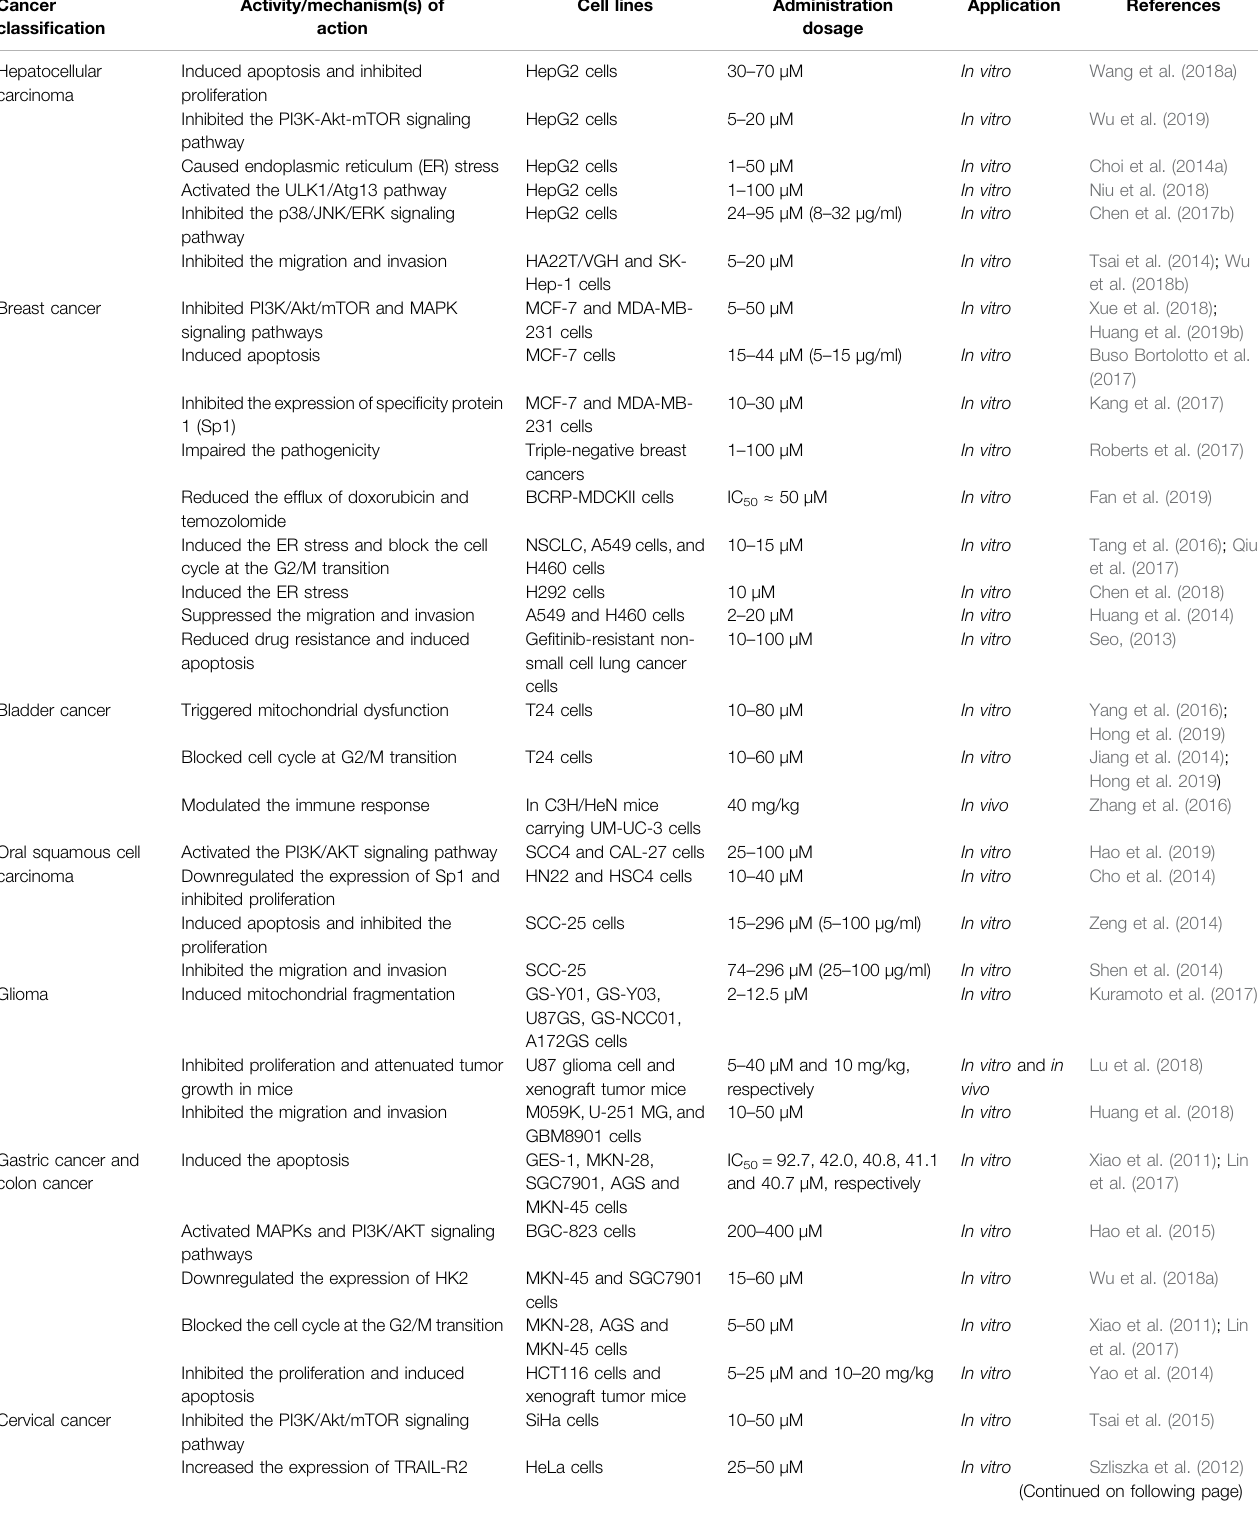
TABLE 1 | The anticancer effects of licochalcone